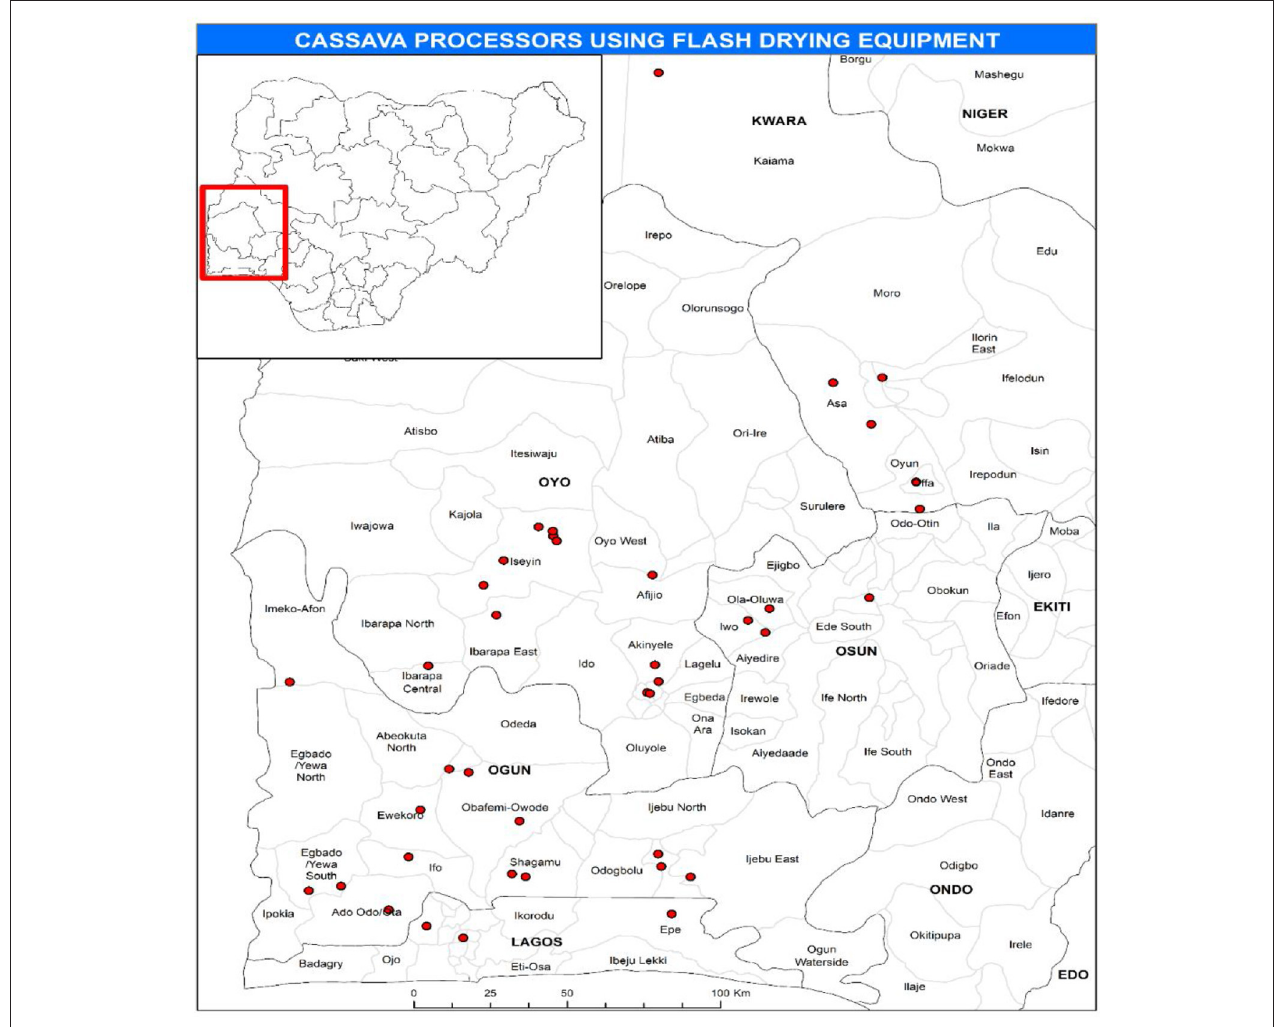
FIGURE 2 | Cassava processors with flash drying equipment. Source: Survey by the authors (November and December